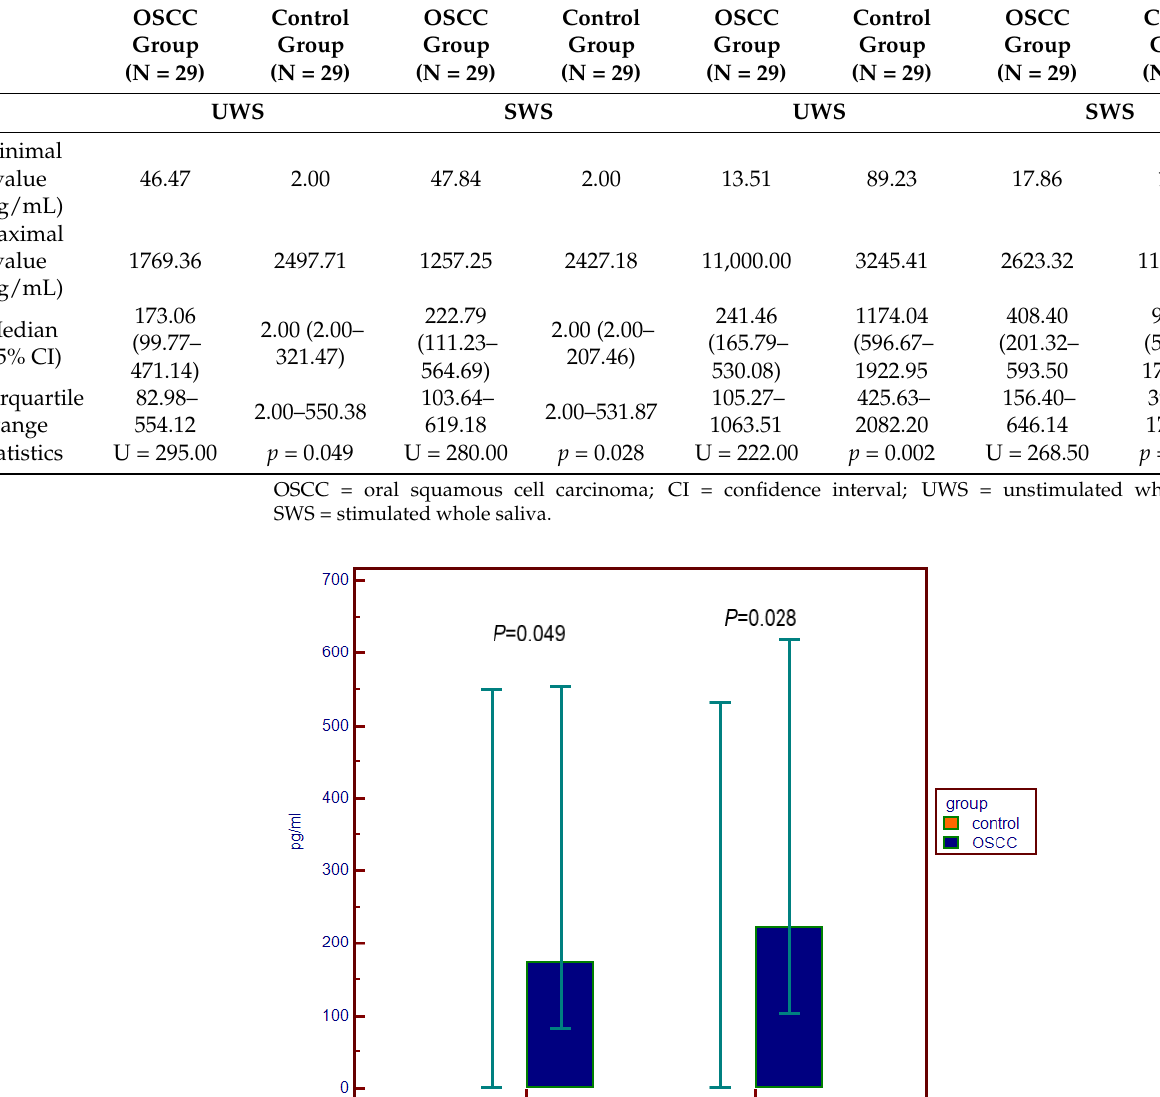
Figure 2. SCCA2 levels (pg/mL) in unstimulated whole saliva (UWS) and stimulated whole saliva (SWS) in patients with oral squamous cell carcinoma (OSCC) and in the control group expressed with median and the 25th–75th percentiles.